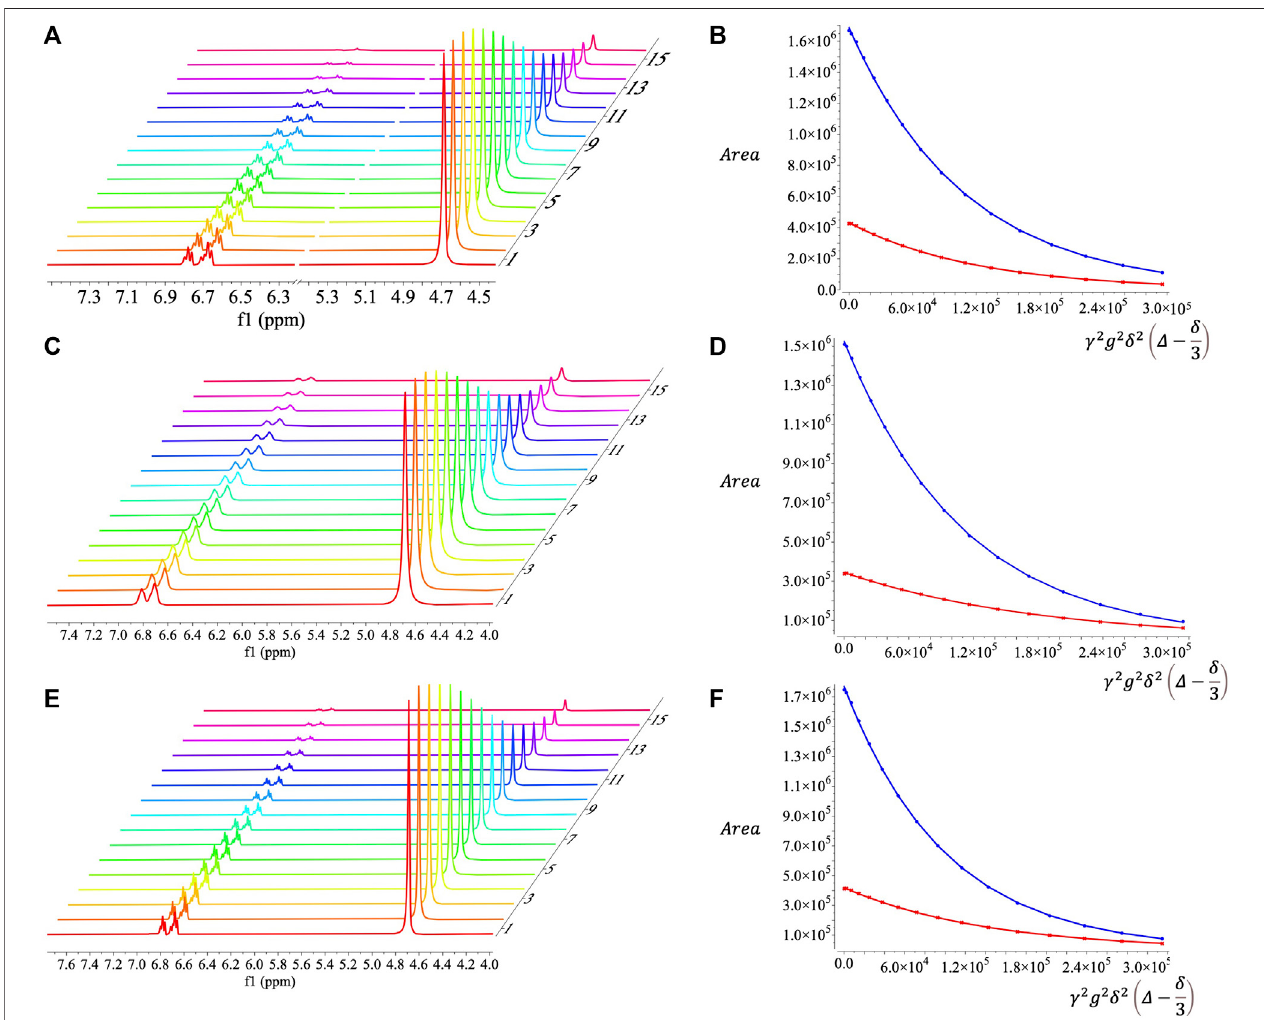
FIGURE 5 | Diffusion NMR spectra and fi ts for decaying signal peak area as a function of gradient strength for (A, B) SDS microemulsions, (C, D) SDS microemulsions with ferrocene, and (E, F) SDS microemulsions with menadione. Red and blue curves in (B, D, F) correspond to peak areas for protons in toluene and water, respectively.